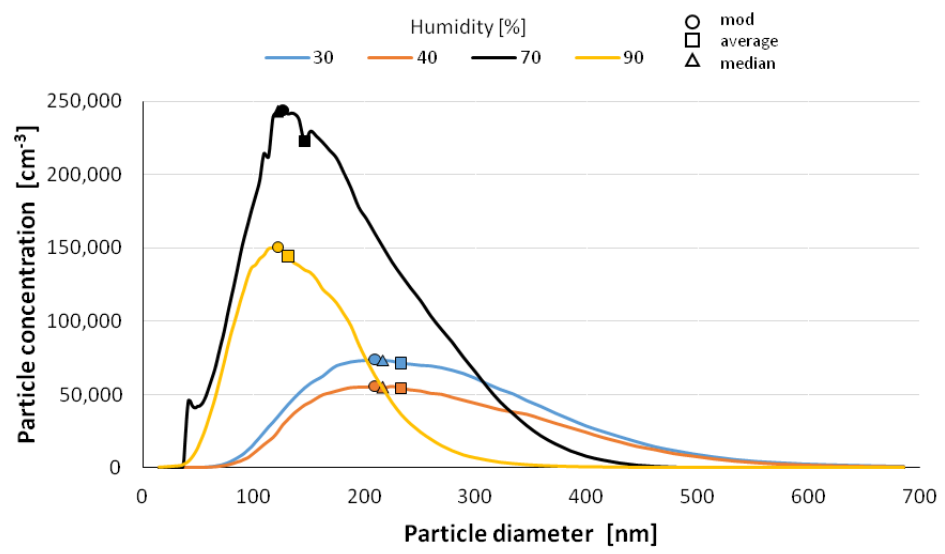
Figure 6. Size distribution of superfine particles 120 sec after atomization.